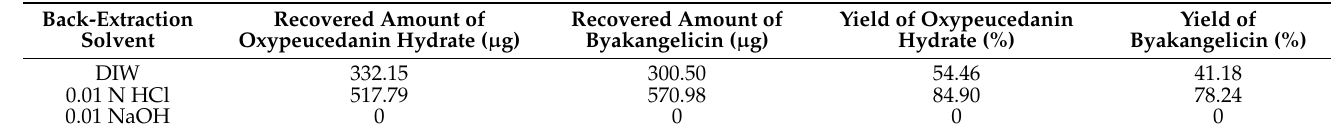
Table 5. Recovery of oxypeucedanin hydrate and byakangelicin. Back-Extraction